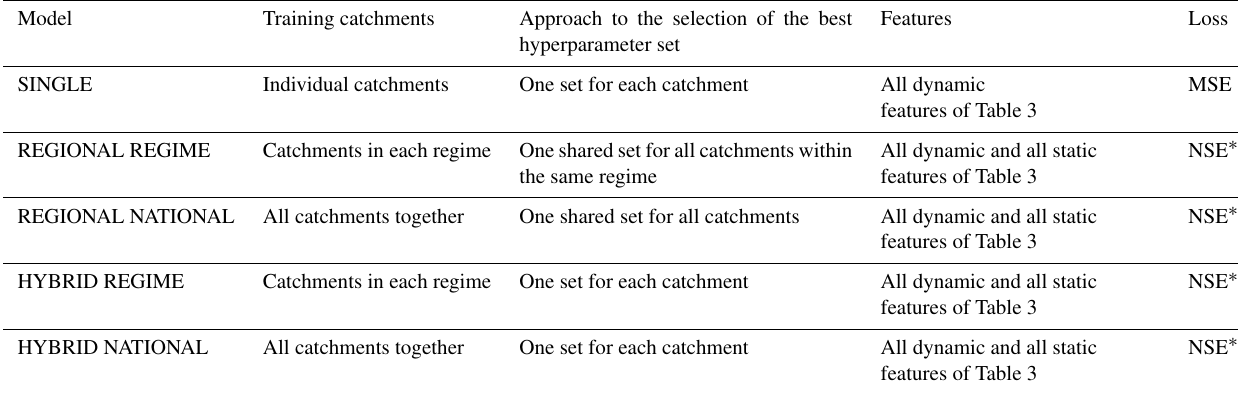
Table 4. Names, training catchments, approaches to the selection of the best hyperparameter set, and features used for the five LSTM models in the